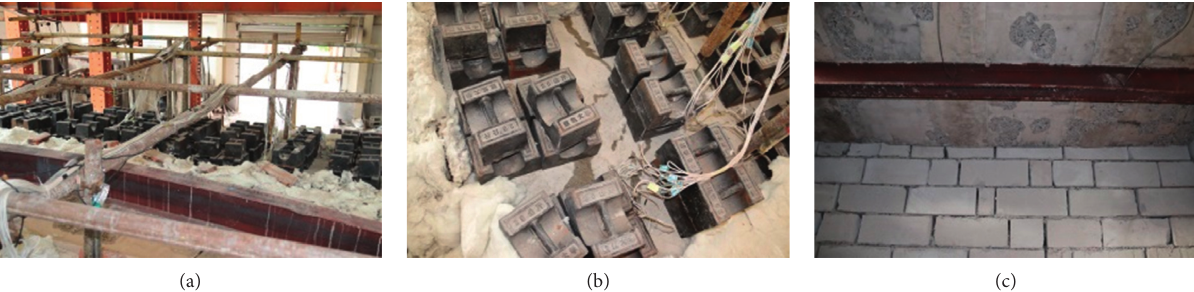
Figure 8: Failure modes of SCB-3: (a) vertical deflection, (b) water spots, and (c) local bursts on the bottom surface of the